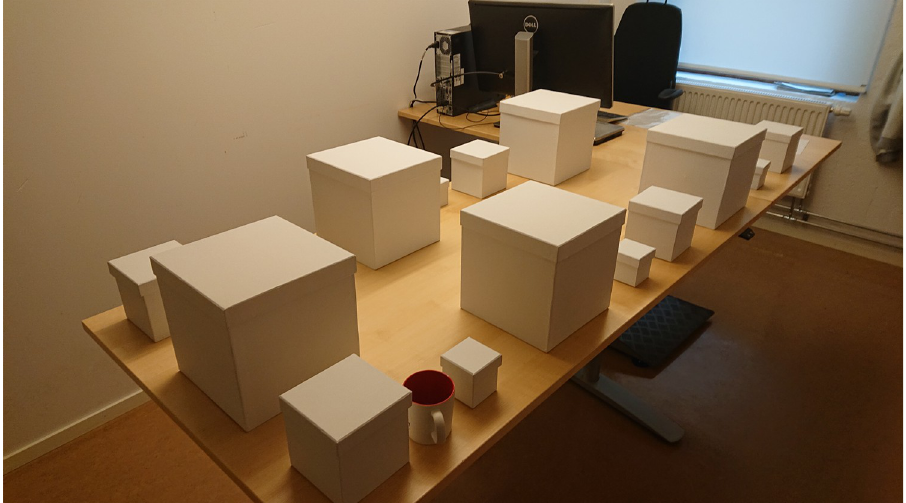
Fig 1. Photograph of the arrangement of the 15 boxes before the first session. Participants were asked to judge the weight of the mug, shown in the photo, before the experiment as an introduction to the lifting task. The experimenter sat behind the computer screen at the back and recorded the responses from the participant as they estimated the weight of the boxes one by one, starting with the medium box at the top right of the photo.